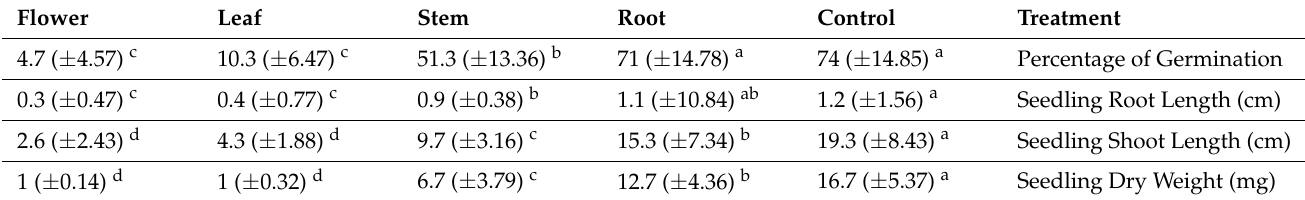
Table 1. Effect of extracts from different organs of N. meyeri on germination and vegetative traits in C. campestris seedling. Numbers represent mean and ± standard deviations. Different letters indicate statistically significant differences calculated by independent ANOVA analyses ( n = 3, p -value < 0.05) for each phenotype followed by multiple mean comparison using Duncan